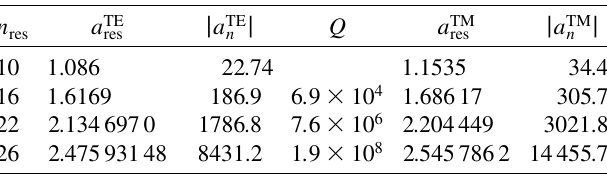
TABLE I. Selected resonance parameters, (cid:1) (cid:2) 4 . n res